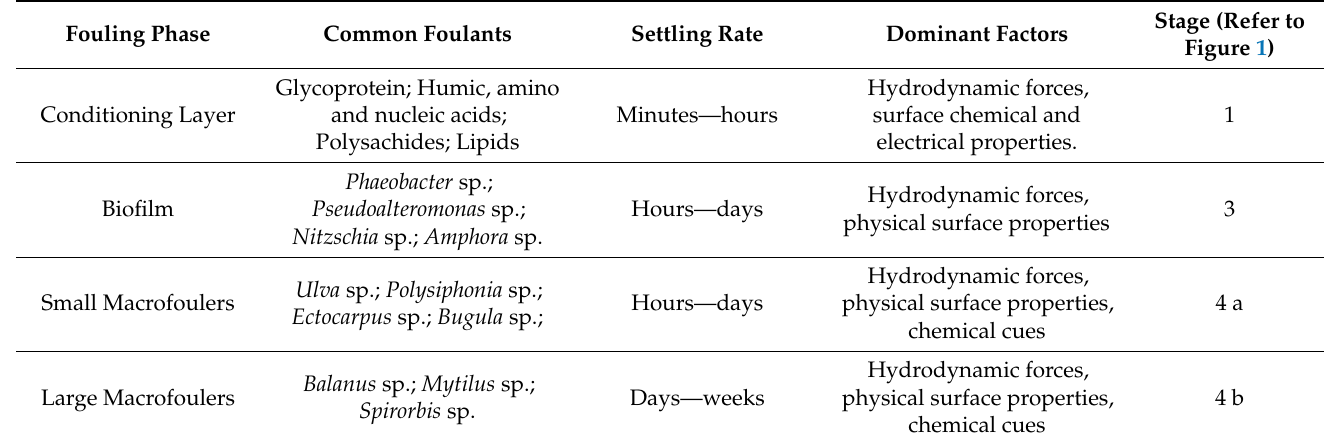
Table 1. Fouling information at different